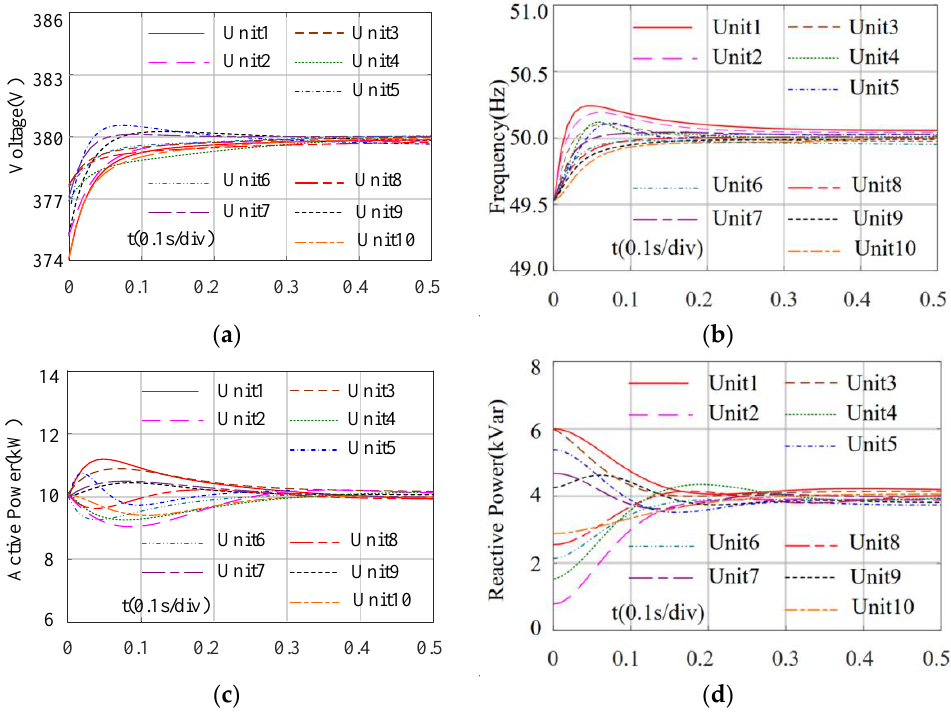
Figure 9. The simulation results with the proposed control strategy in this paper. ( a ) voltage amplitude; ( b ) frequency; ( c ) active power; ( d ) reactive power.